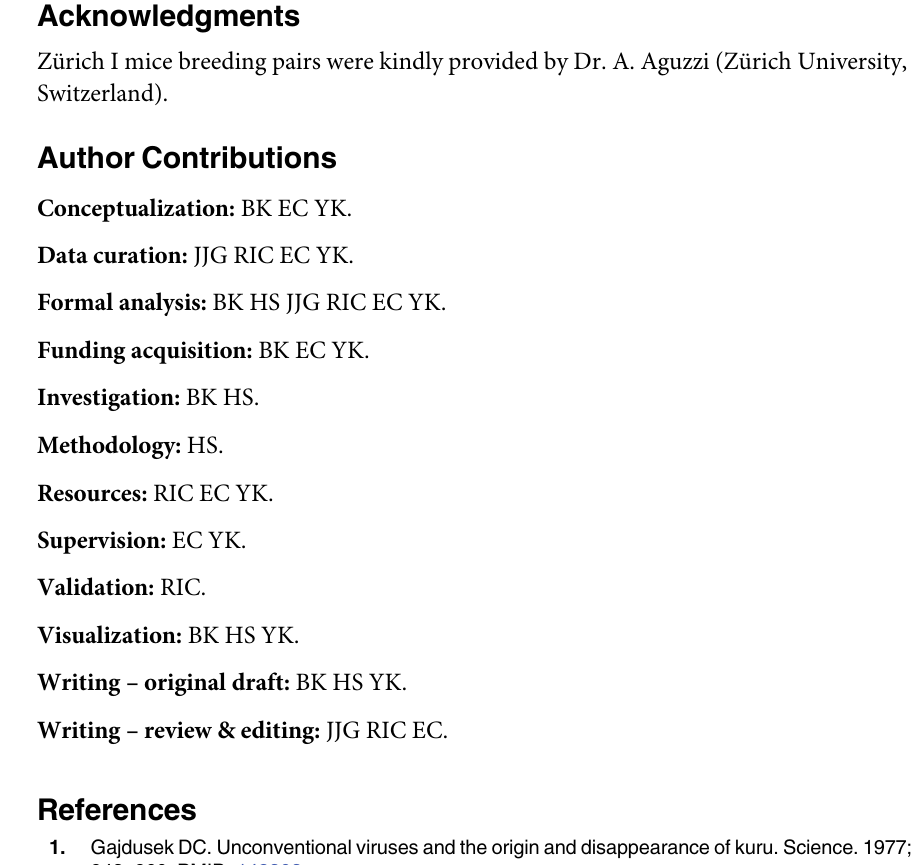
S1 Table. MuLV plaque number assay in PrP -/- and PrP +/+ neuronal and astroglial cell lines. S2 Table. Plaque size of PrP -/- and PrP +/+ neuronal and astroglial cell